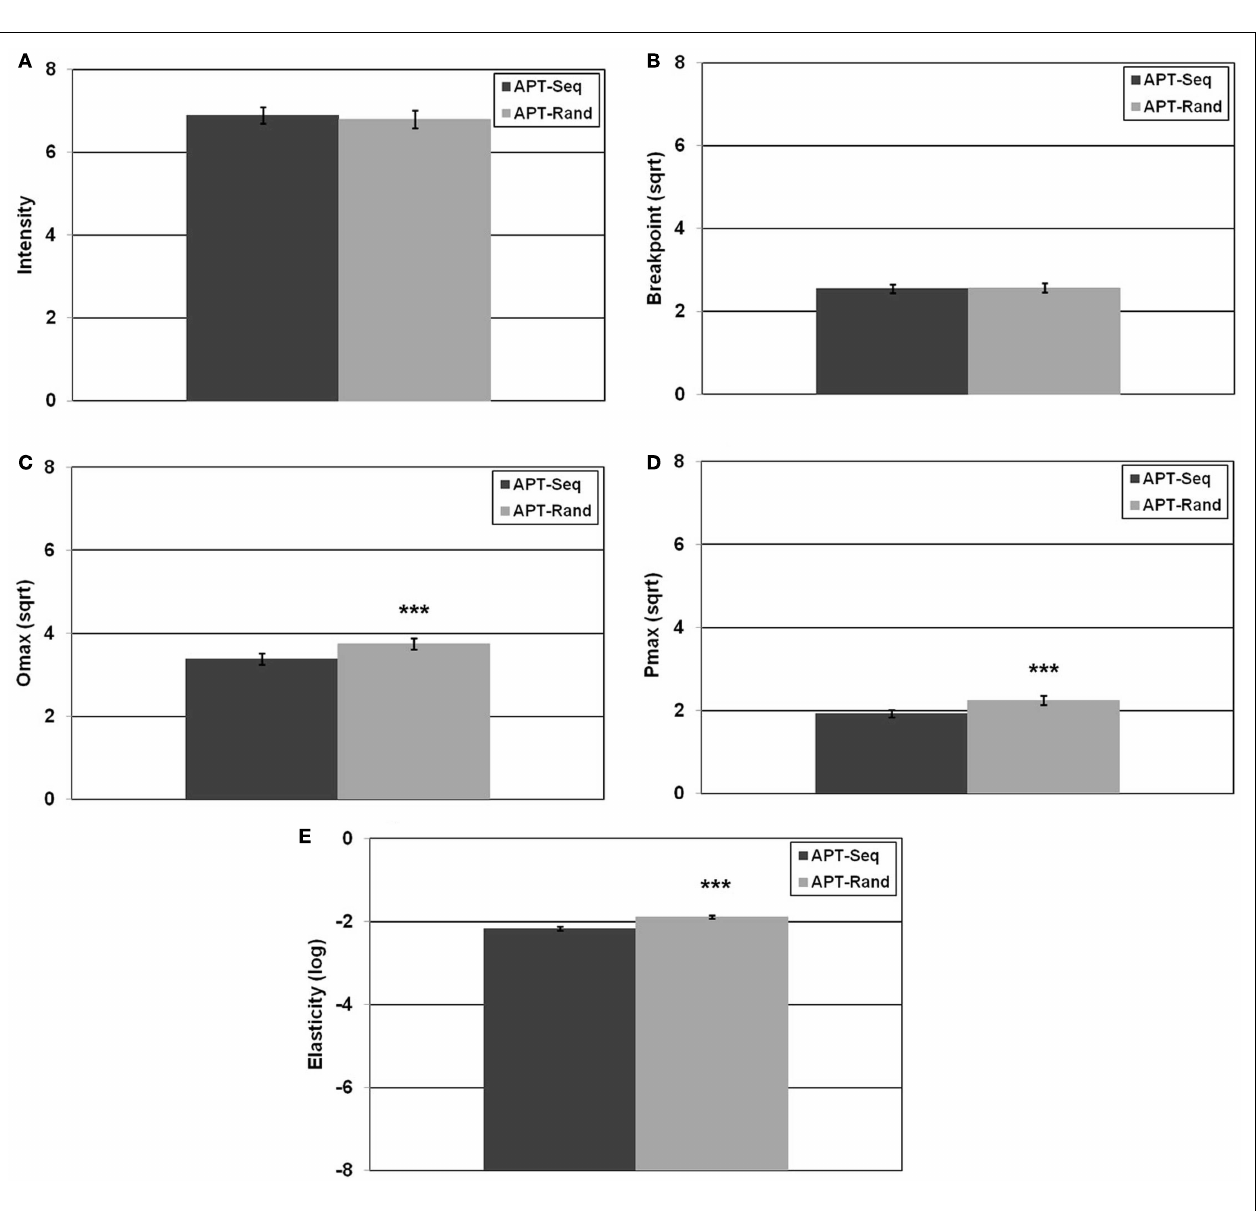
(C) Depicts square-root transformed O max . (D) Depicts square-root transformed P max . (E) Depicts logarithmically transformed elasticity ( α ). Individual bars represent mean ( ± standard error). Note, N = 91; *** p <